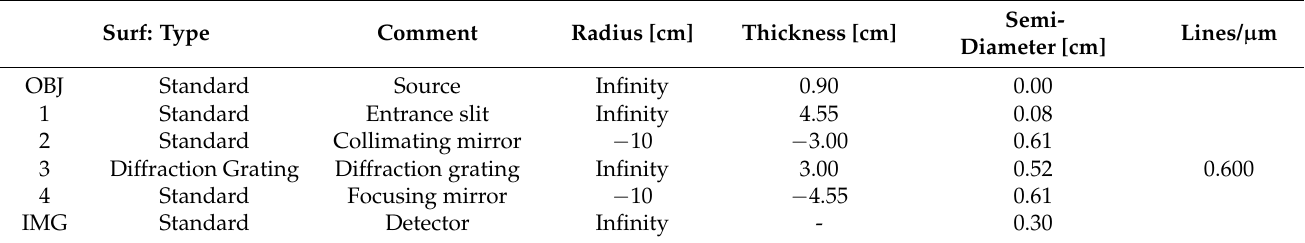
Table 1. Lens data editor window for the design of an optical spectrometer in